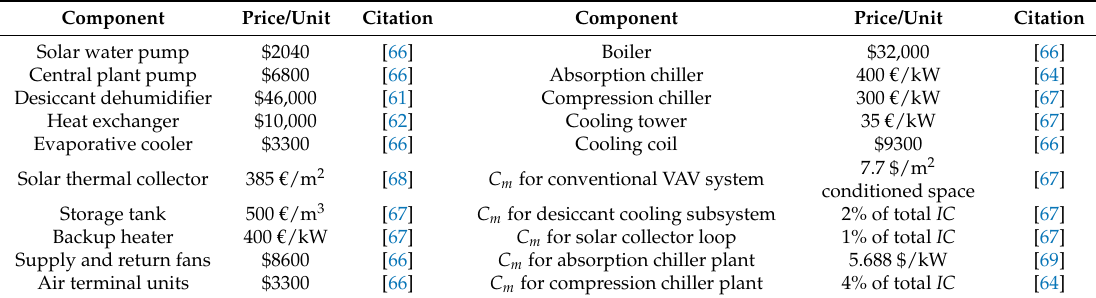
Table 12. Assumptions of system equipment costs and O&M costs.